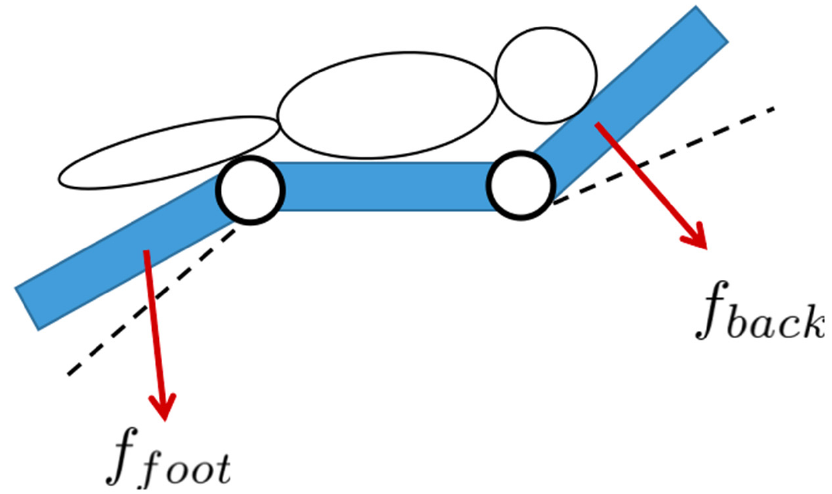
Figure 13. An illustration of the complex dynamics.